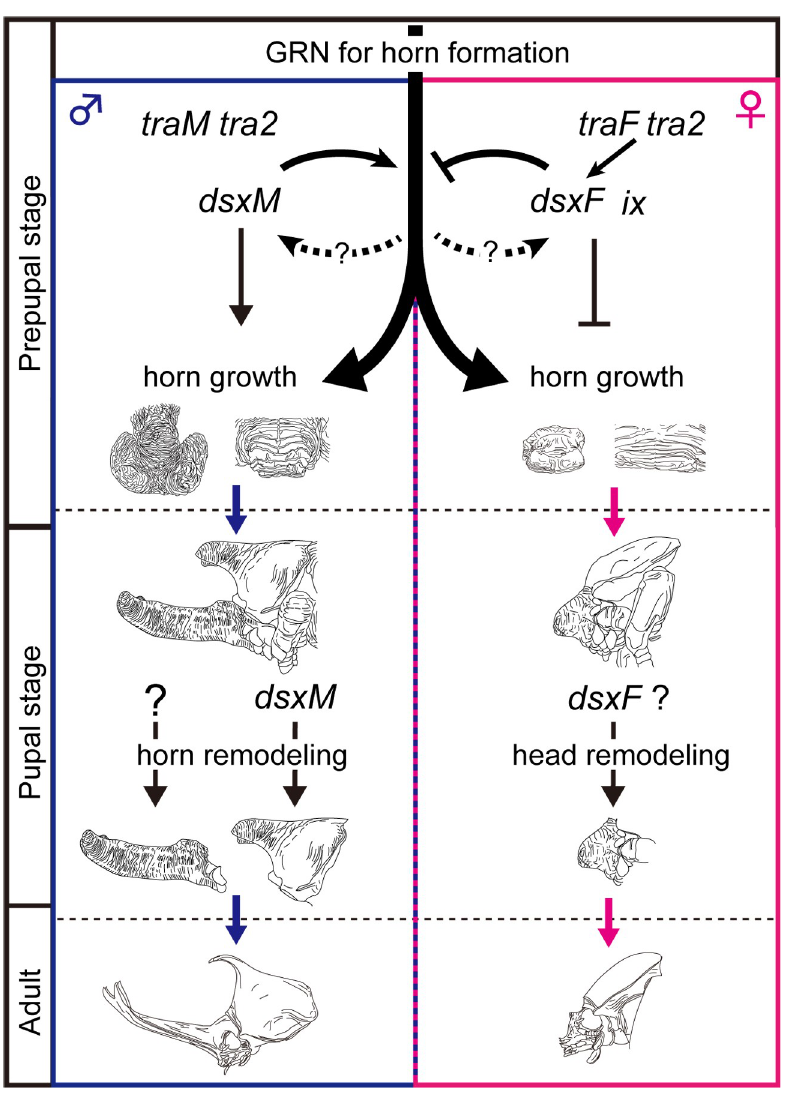
Fig 8. A regulatory model for the formation of sexually dimorphic horns in T . dichotomus . In males, default splicing generates Tdic-dsxM , whereas in females, Tdic-tra (a female isoform, traF ) and Tdic-tra2 , generates Tdic-dsxF by female-specific splicing of Tdic-dsx pre-mRNA. Prepupal Tdic-dsxM expression in males positively regulates the growth of head and thoracic horn primordia, whereas prepupal Tdic-dsxF in females suppresses the horn growth activity. In pupa, Tdic-dsxM regulates thoracic horn remodeling, but is dispensable for remodeling of head horn. GRN, gene regulatory network.